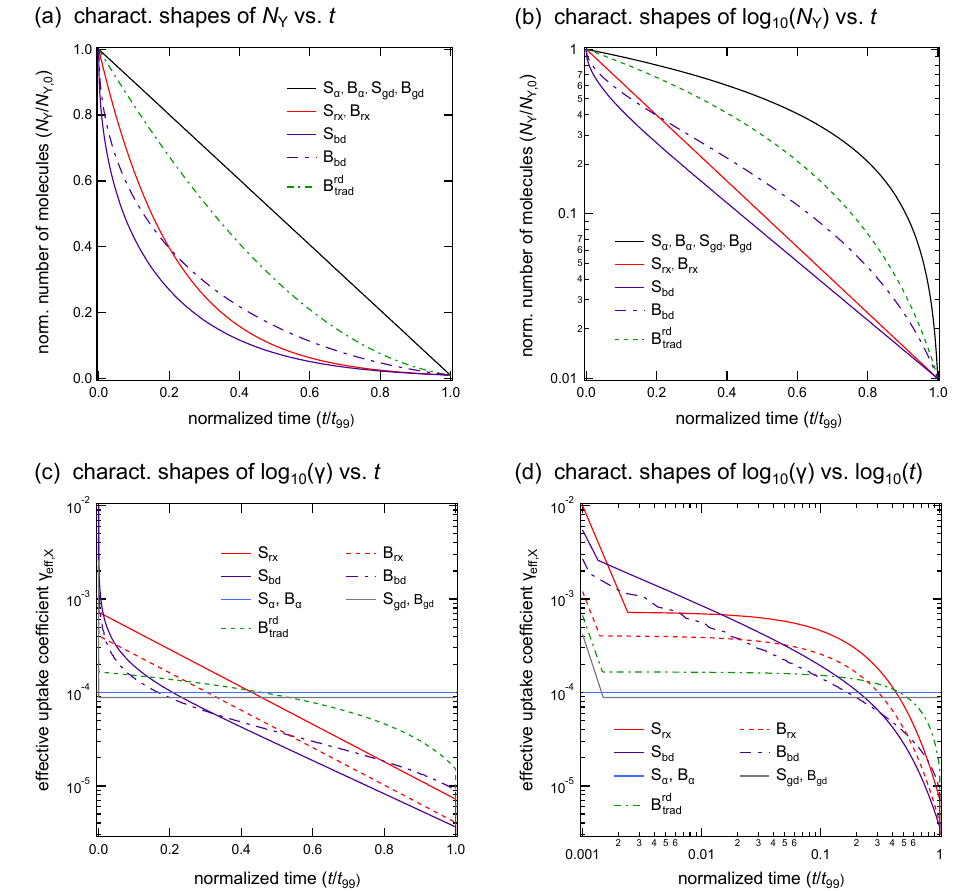
Fig. 5. Normalised representation of the decay shapes of the total amount of Y ( N Y , panels a and b ) and the effective reactive uptake coefficient ( γ eff,X , panels c and d ) for all limiting cases on linear and logarithmic time scales (see Sect. 5.1 for a more complete description). In addition to the eight regular limiting cases, we also display the traditional reacto-diffusive case, B rd case, but a distinct scenario in the reaction-diffusion